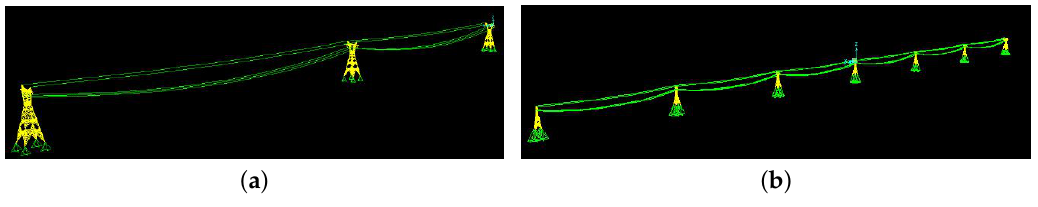
Figure 7. Interaction among towers. ( a ) Tower-line with three towers; ( b ) Tower-line with seven towers.